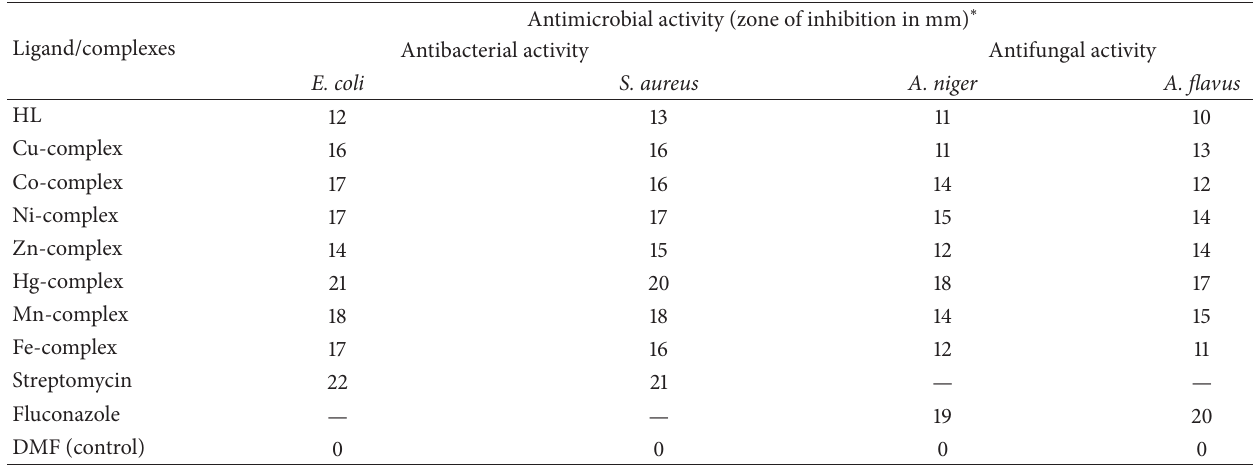
Table 8: Antimicrobial activity screening data of the ligand HL and its complexes.